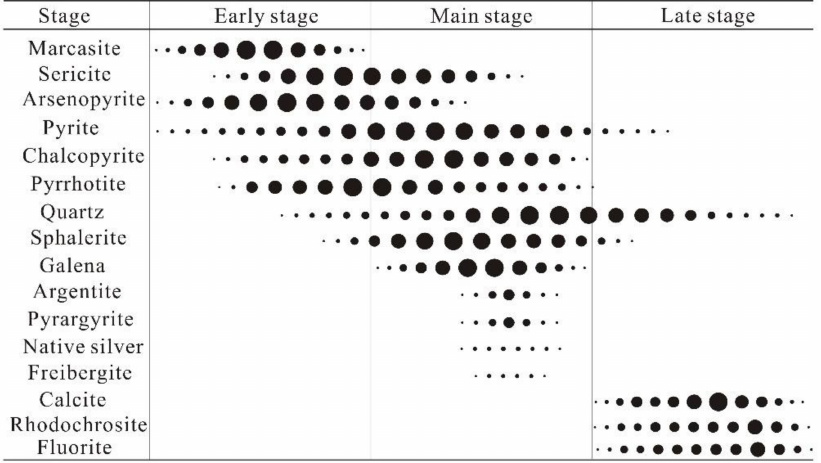
Figure 5. Stages of mineralization and the paragenetic sequence of minerals in the Yingfang